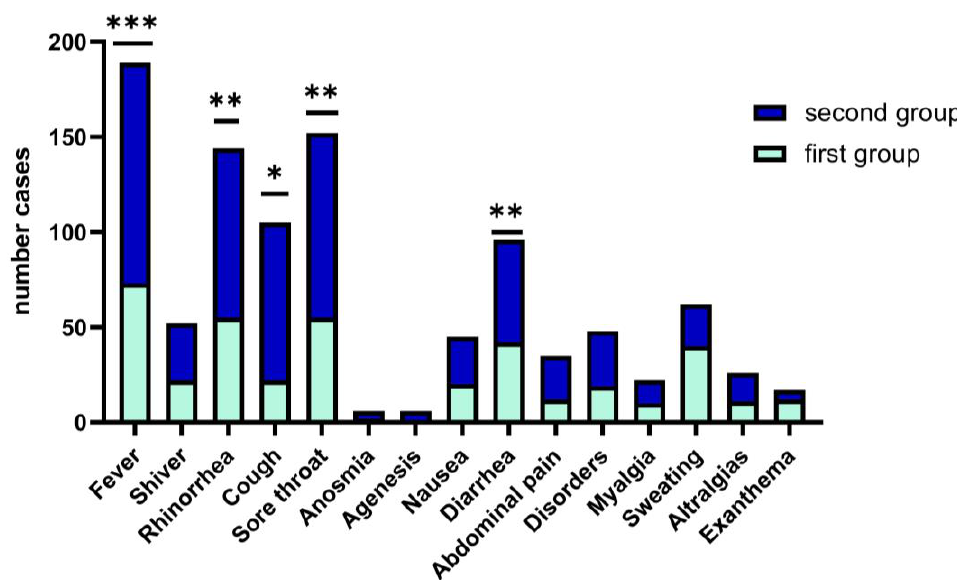
Figure 2. Wilcoxon matched-pairs signed rank test. Clinical features of COVID-19 in children between the two groups. Data are represented as the number frequency of the symptoms in each group, p -value (two tailed, was significantly effective, * — p ≤ 0.05 , ** — p ≤ 0.01, *** — p ≤ 0.001 ).